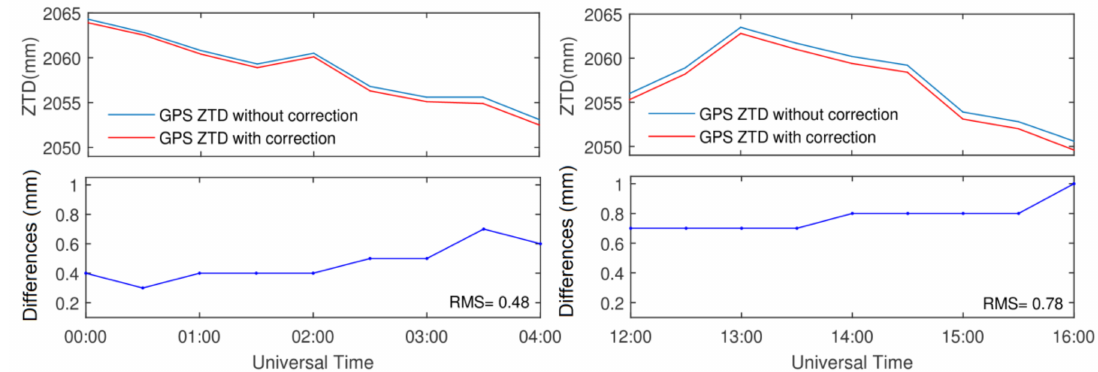
Figure 4. ZTD time series ( top ) and di ff erences ( bottom ) at ANRK station during the night ( left ) and the day ( right ) on day 167 in 2011.